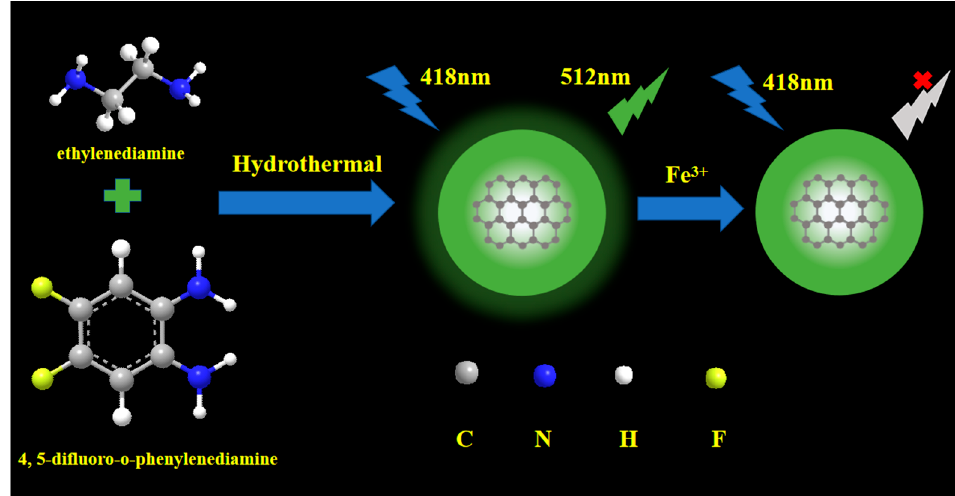
Scheme 1. One-pot hydrothermal synthesis of green fluorescent